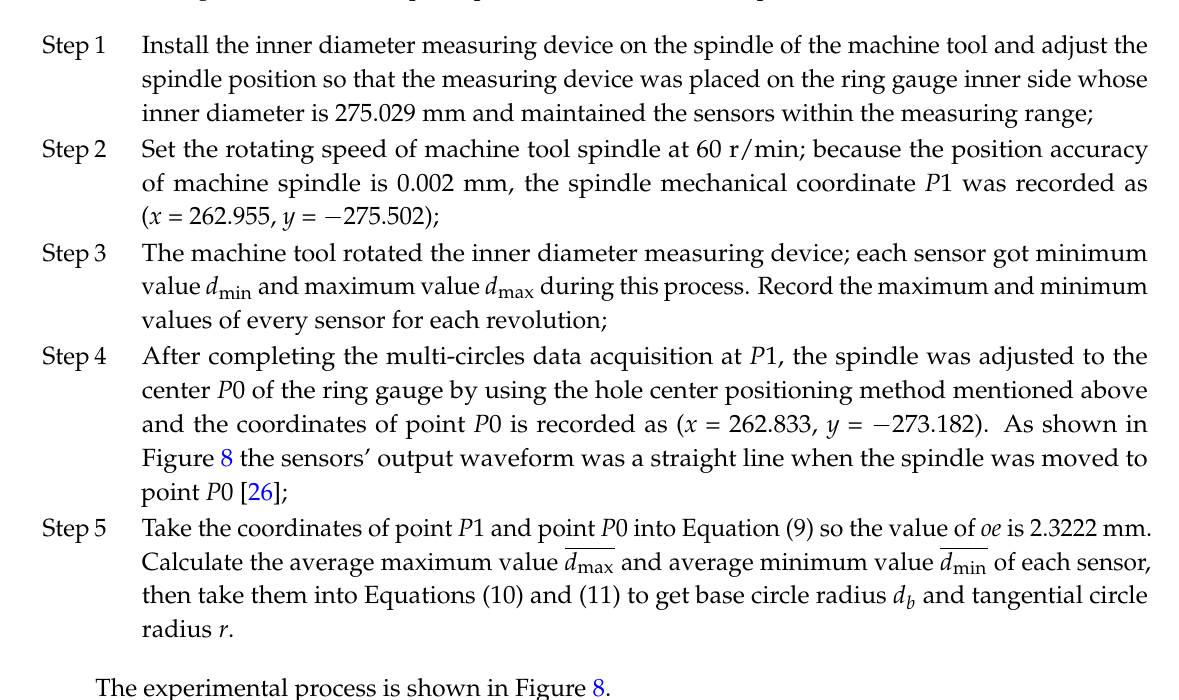
Figure 7. Effects of θ x and θ y on the value of d ( d ) d = 10.0 mm.